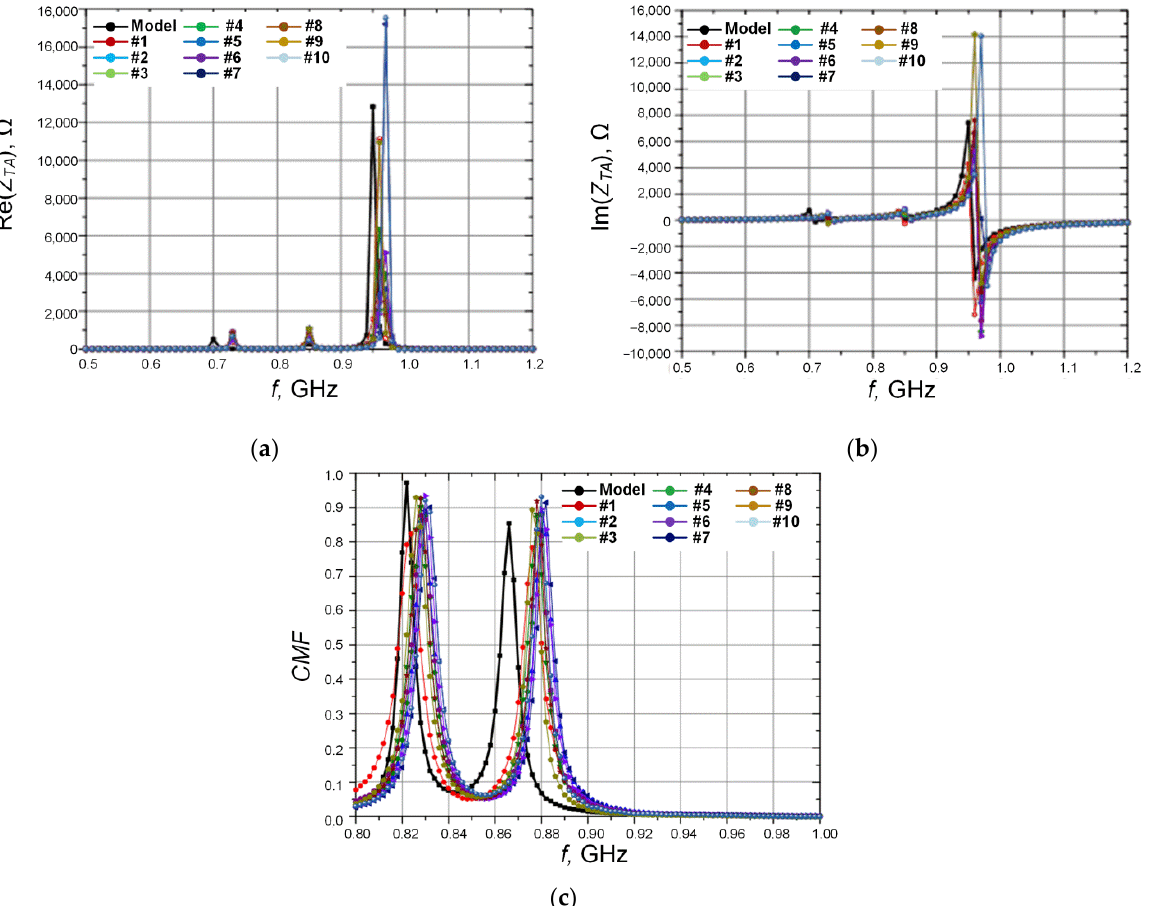
Figure 9. Parameters of RF front-end in RFID sensor under tests: ( a ) antenna impedance Z TA — resistance; ( b ) antenna impedance Z TA — reactance; ( c ) power transfer coefficient CMF .